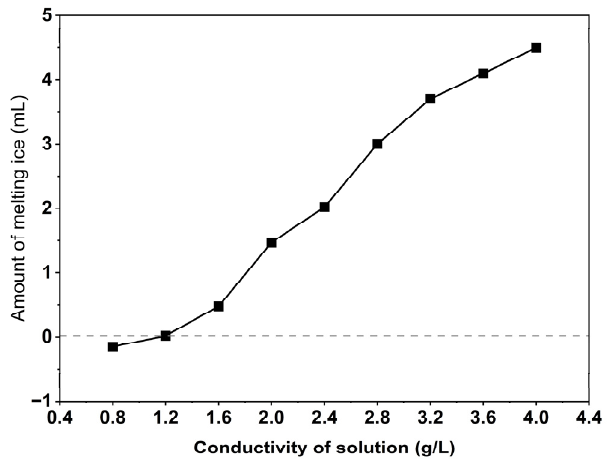
Figure 12. The amount of ice melting in the gradient concentration solution.